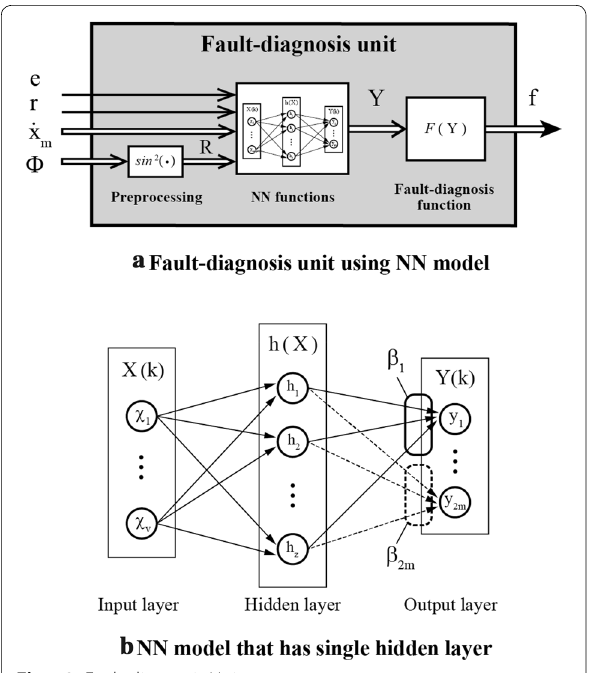
Fig. 10 Fault-diagnosis